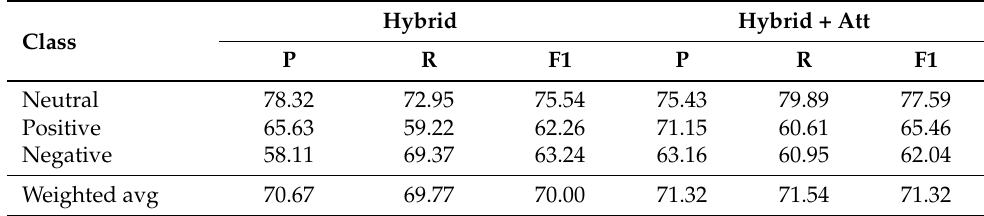
Table 7. Performance of hybrid model w/o